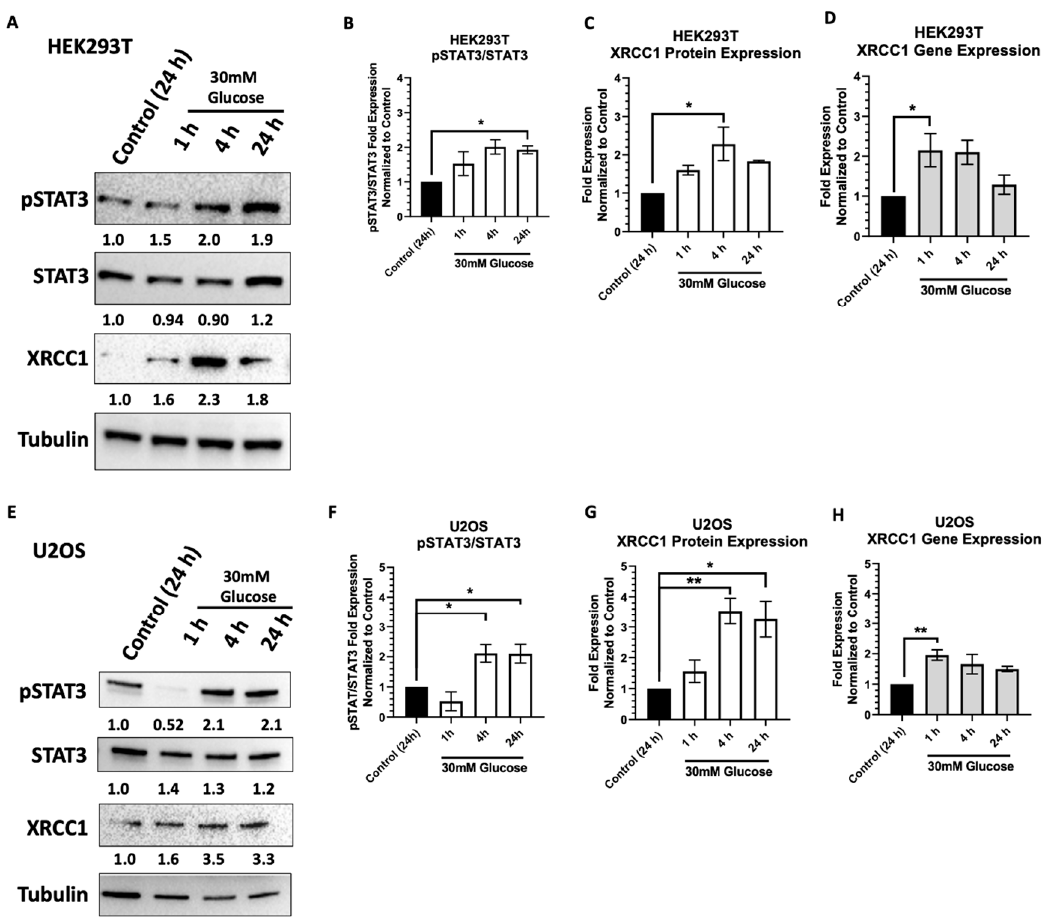
Figure 1. High glucose activates STAT3, subsequently increasing XRCC1 protein and gene expression. ( A ) Representative immunoblot showing increased XRCC1 following acute high glucose (30mM) for 1, 4, and 24 h in HEK293T, including mean values for three biological replicates. ( B ) pSTAT3 relative to total STAT3 in HEK293T normalized to loading control then control, untreated. ( C ) XRCC1 protein expression in HEK293T normalized to control. ( D ) XRCC1 gene expression in HEK293T normalized to control. ( E ) Representative immunoblot showing increased XRCC1 following acute high glucose (30 mM) for 1, 4, and 24 h in U2OS, including mean values for three biological replicates. ( F ) pSTAT3 relative to total STAT3 in U2OS normalized as described in B. ( G ) XRCC1 protein expression in U2OS normalized to control. ( H ) XRCC1 gene expression in U2OS normalized to control. * p < 0.05, ** p < 0.01.